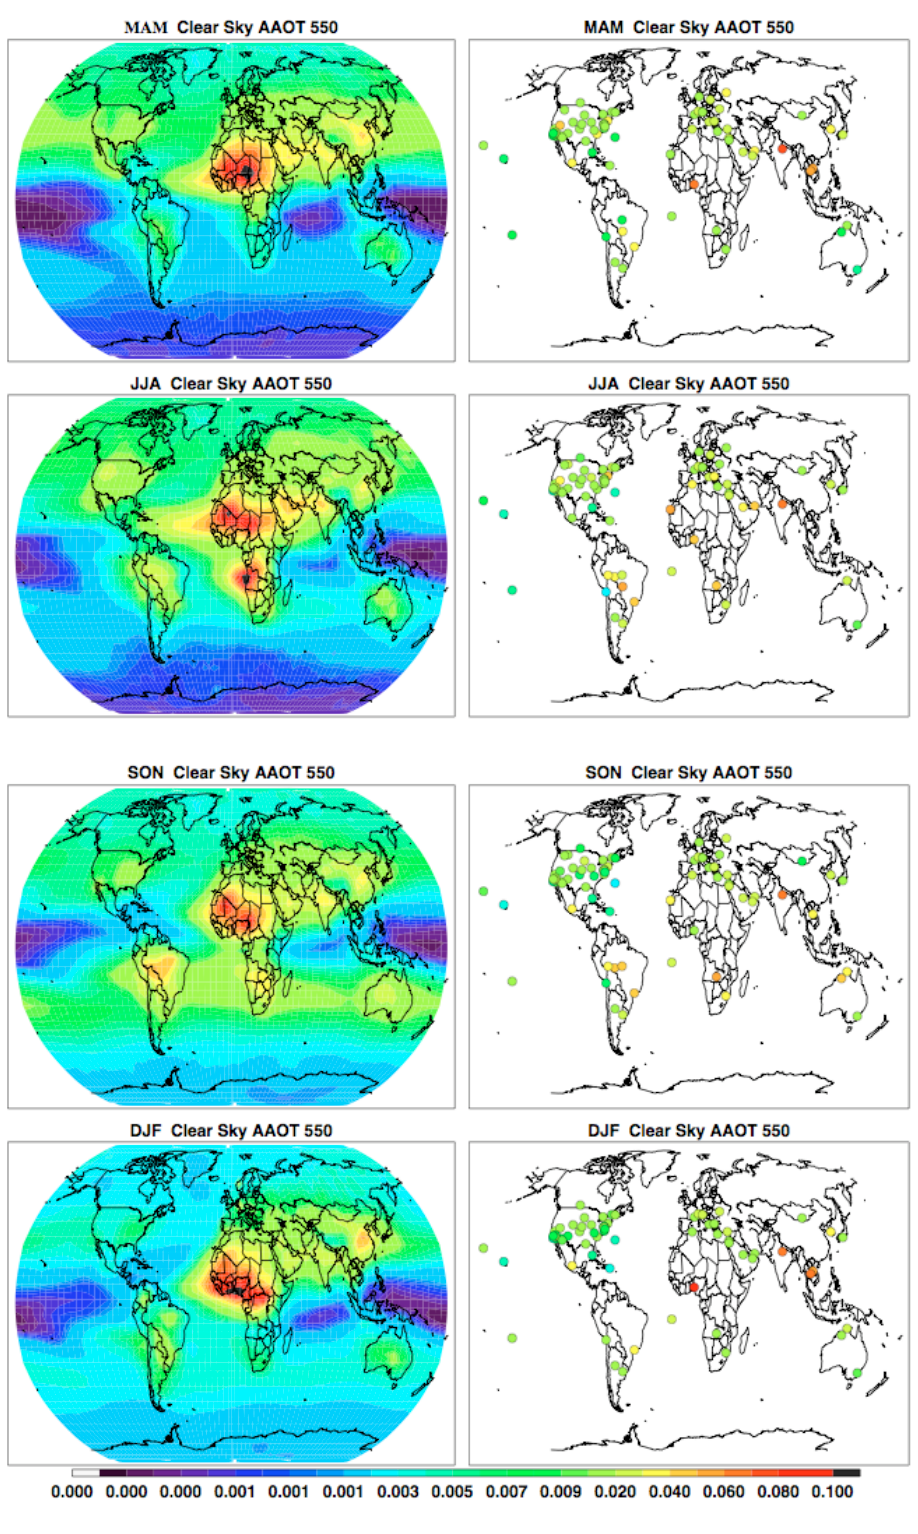
Fig. 7. Aerosol absorption optical thickness at 550 nm for clear sky conditions shown for the four seasons. Left column shows model data and in the right column AERONET